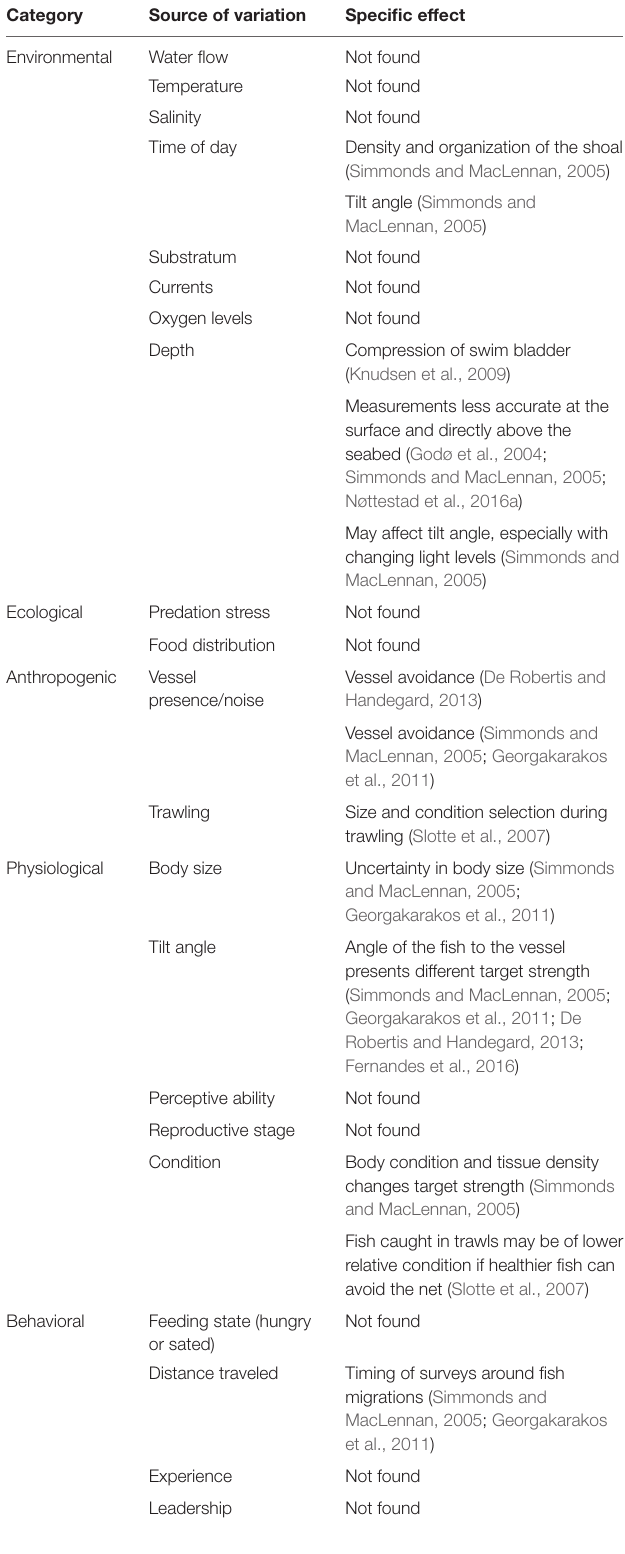
TABLE 3 | Potential sources of variability in the acoustic survey process (beyond standard calibration settings accounting for local conditions and vessel/echosounder capacity), if found in the literature, and the specific effect, if